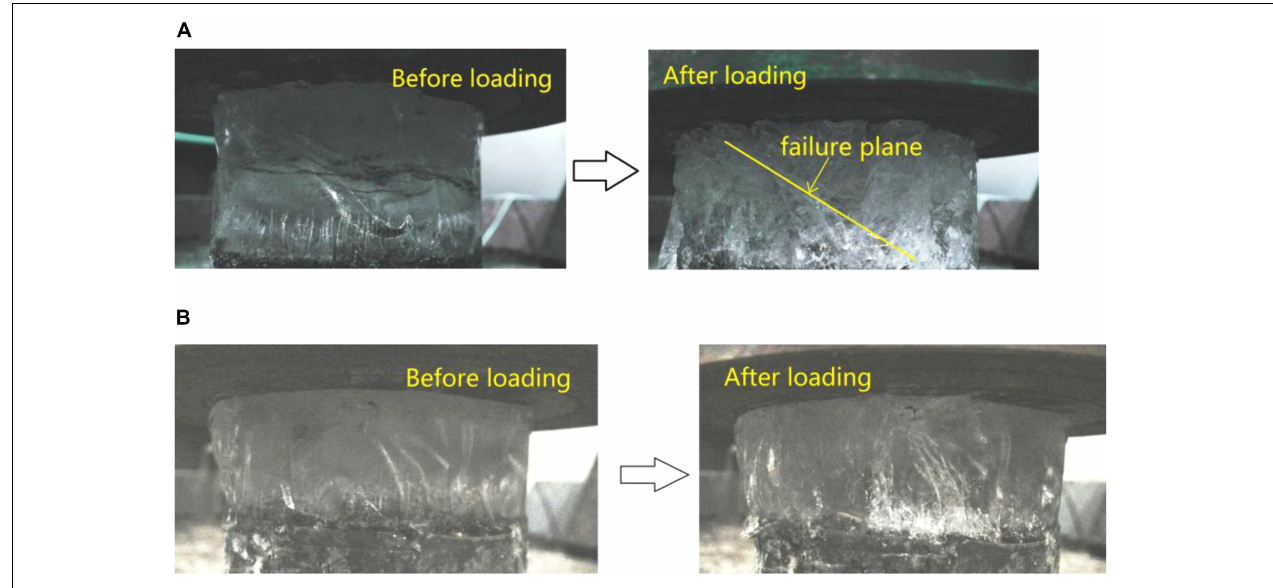
FIGURE 11 | (A) Ice specimen before and after compressive test for –6.3 ◦ C. (B) Ice specimen before and after compressive test for − 0.7 ◦ C.